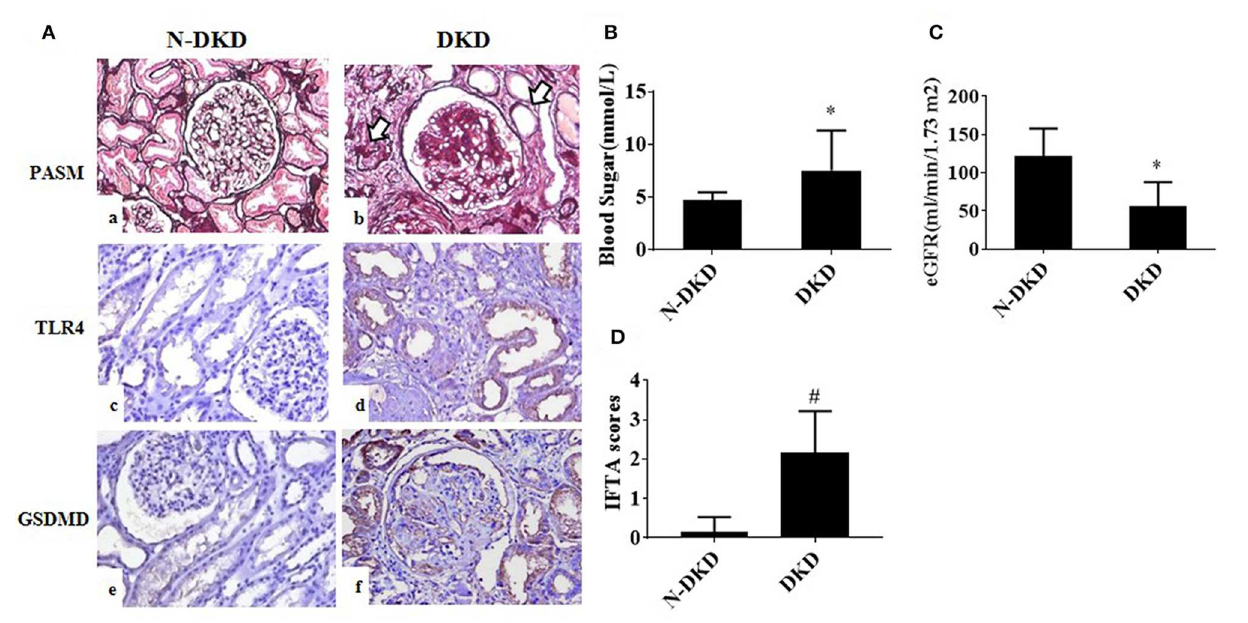
FIGURE 1 | TLR4 and GSDMD were increased in renal tubules of DKD patients. (A) PASM staining in renal biopsy specimens of patients with Non-DKD(N-DKD) (a) and DKD (b) (arrow indicates focal tubular atrophy and interstitial fibrosis) (magnification × 200). Immunohistochemistry staining demonstrated the expression of TLR4 in renal biopsy tissues of patients with DKD (d) vs. N-DKD (c), and expressions of GSDMD in renal biopsy tissues of patients with DKD (f) versus N-DKD (e). (B–D) Blood glucose, eGFR levels, and IFTA scores in DKD and NDKD patients. Values are means ± SEM. * P < 0.05, # P < 0.01.